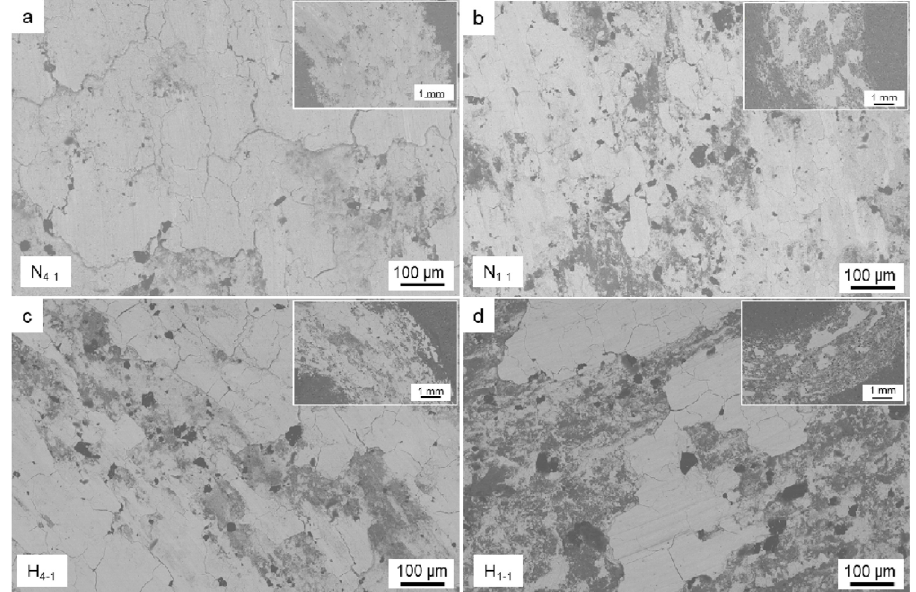
Figure 7. Magnified view of the worn surfaces of the Al/diamond composites under different con- ditions with the insert image showing the whole worm track [56]. conditions with the insert image showing the whole worm track